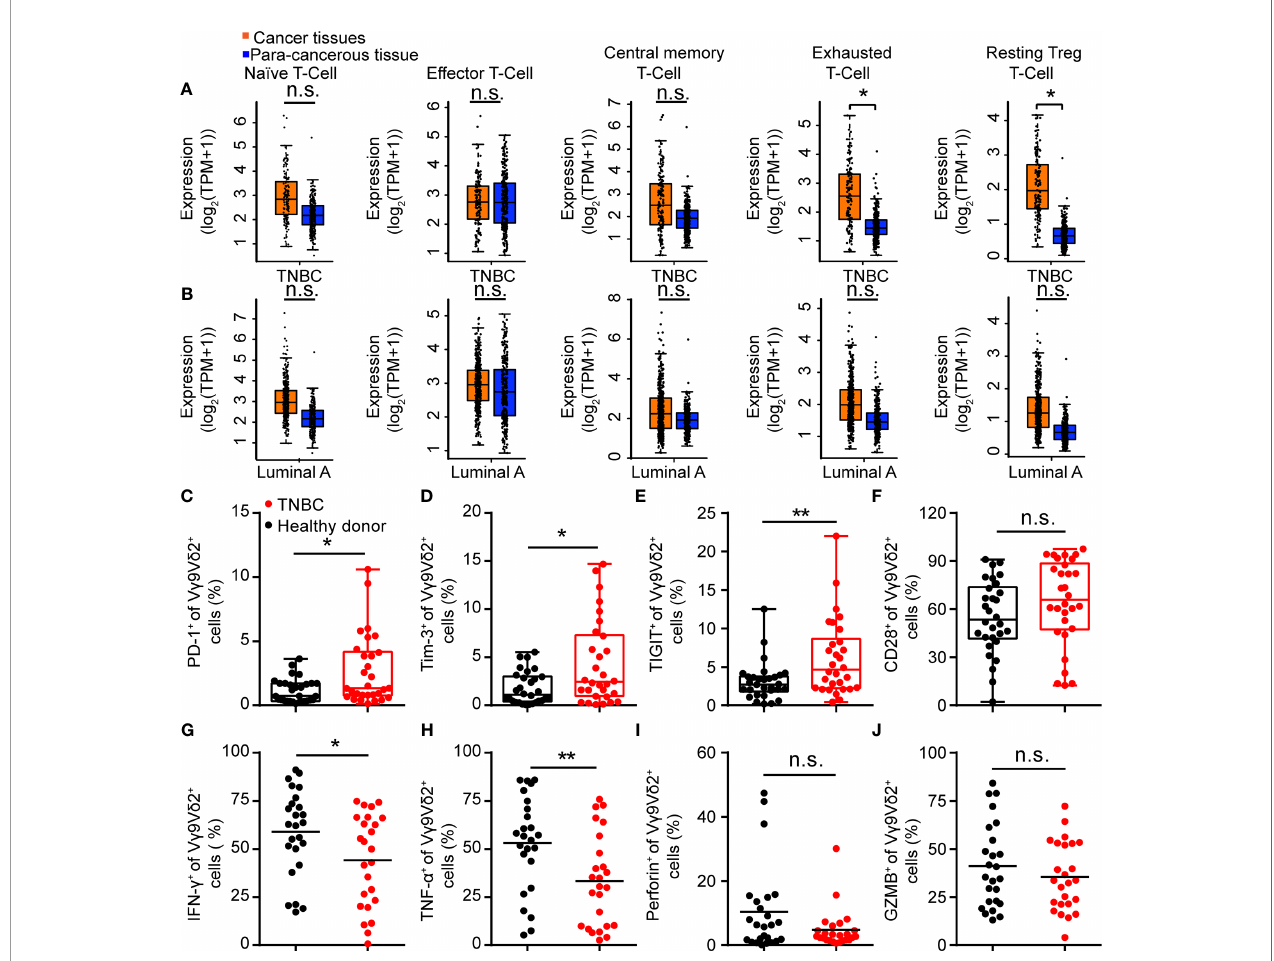
FIGURE 2 | Immune checkpoint receptors were highly expressed on V g 9V d 2 T cells in triple negative breast cancer patients. (A, B) Expression of T cell function- associated genes in TNBC and luminal A cancers from the GEPIA dataset (TNBC, n =135, luminal A, n =415). Cancer tissues (orange box) were compared with para- cancerous tissues (blue box, n =291). Signatures Gene Set: Naïve T-cell ( CCR7, LEF1, TCF7 , and SELL ), effector T-cell ( CX3CR1, FGFBP2 , and FCGR3A ), central memory T-cell ( CCR7, SELL , and IL7R ), exhausted T-cell ( HAVCR2, TIGIT, LAG3 , and PDCD1 ), and resting Treg T-cell ( FOXP3 and IL2RA ). The method for differential analysis was one-way ANOVA, using disease state (Tumor or Normal) as variable for calculating differential expression (A, B) . (C – F) Expression of PD-1 + (C) , Tim-3 + (D) , TIGIT + (E) , and CD28 + (F) on V g 9V d 2 T cells in healthy donors ( n =30) and triple negative breast cancer patients ( n =30). (G – J) Percentage of V g 9V d 2 T cells producing IFN- g + (G) , TNF- a + (H) , Perforin + (I) , and Granzyme B + (J) in total V g 9V d 2 T cells were from patients with TNBC ( n =25) and healthy donors ( n =25), and stimulated with 50 ng/mL phorbol 12-myristate 13-acetate (PMA) and 1 m g/mL ionomycin (Ion) in vitro . Unpaired Student ’ s t -test (F – H, J) ; Mann − Whitney